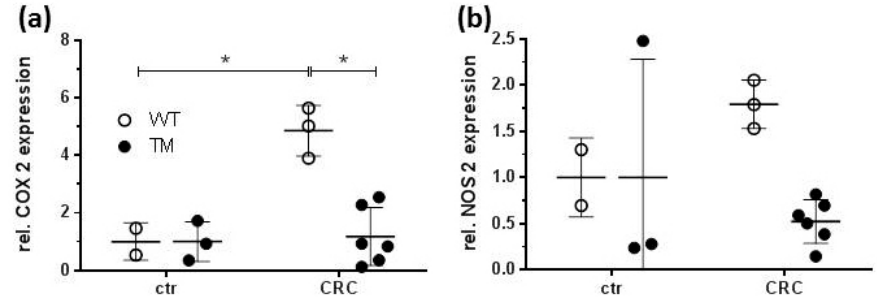
Figure 5. RNA was isolated from colon samples out of the mice described in Figure 1. The concentrations of mRNA encoding COX 2 and NOS 2 were quantified by RT-qPCR. ( a,b ) Relative mRNA expression of ( a ) COX2 and ( b ) NOS2. WT: wild type, TM: H 4 R − / − , ctr: AOM-treated mice, CRC: AOM / DSS-treated mice. Means +/ − SD of n = 2–6. *, p < 0.05 (two-way ANOVA with Sidak’s post hoc